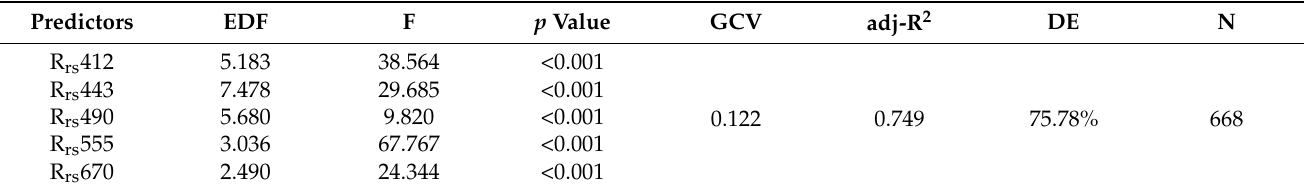
Table 12. Statistical summary of the fitted cyanobacteria GAM.